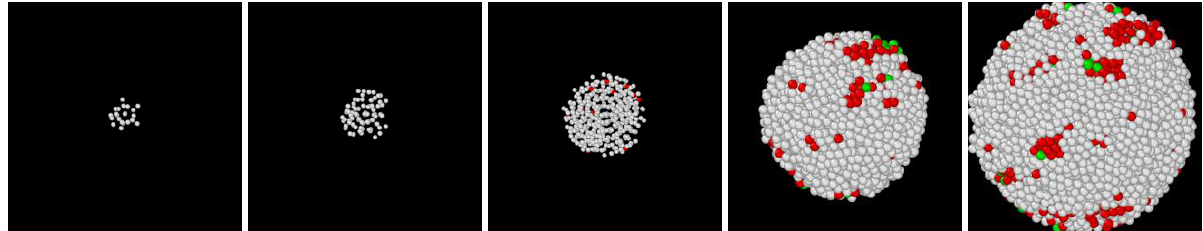
Figure 6. Snapshots of a solid cluster forming in an MPFC simulation performed under the same conditions as the simulation shown in Figure 5. In the left three panels, small spheres are used to indicate the position of the density peaks, which allows us to see the presence of an ordered but non-crystalline initial structure. On the right atom-size spheres are displayed. The snapshots were taken at dimensionless times t = 460, 500, 600, 900, and 1100. The same coloring is used as in Figure 3. A fraction of a 512 3 simulation is shown.